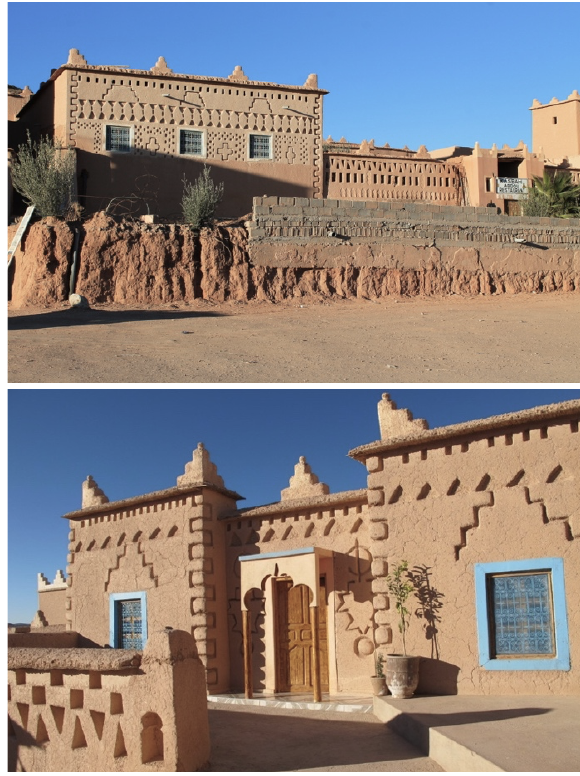
Figure 14 and 15. “Kasbah Abdou” (Source: TripAdvisor).